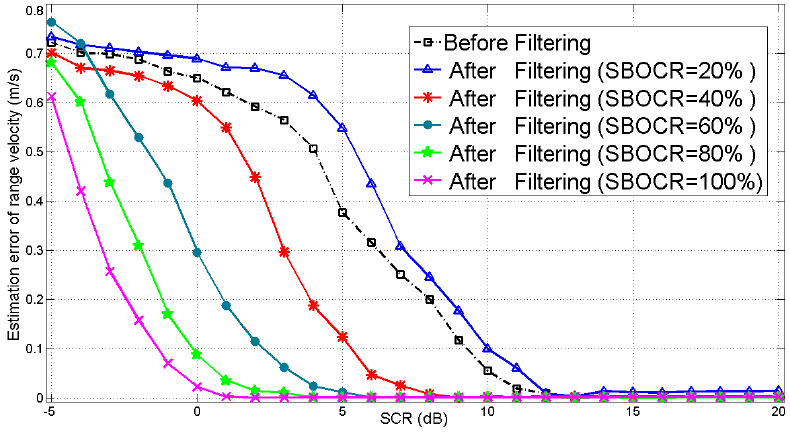
Figure 8. The algorithm performance versus SCR and SBOCR.